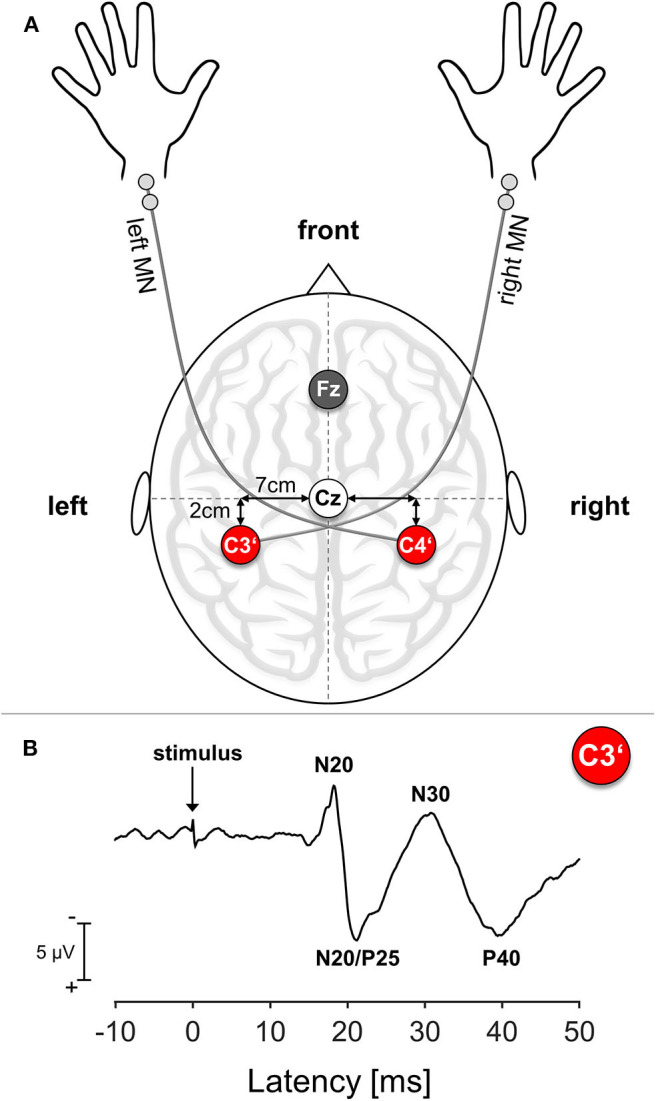
Somatosensory Evoked Potential (SEP): Setup and Exemplary Trace. (A) Schematic SEP electrode setup. MN, median nerve; Cz, Mid of the head; Fz, Reference electrode position; C3′, Electrode position corresponding to left S1; C4′, electrode position corresponding to right S1. (B) Exemplary SEP trace of a representative young participant. The arrow marks the time point of stimulus onset.